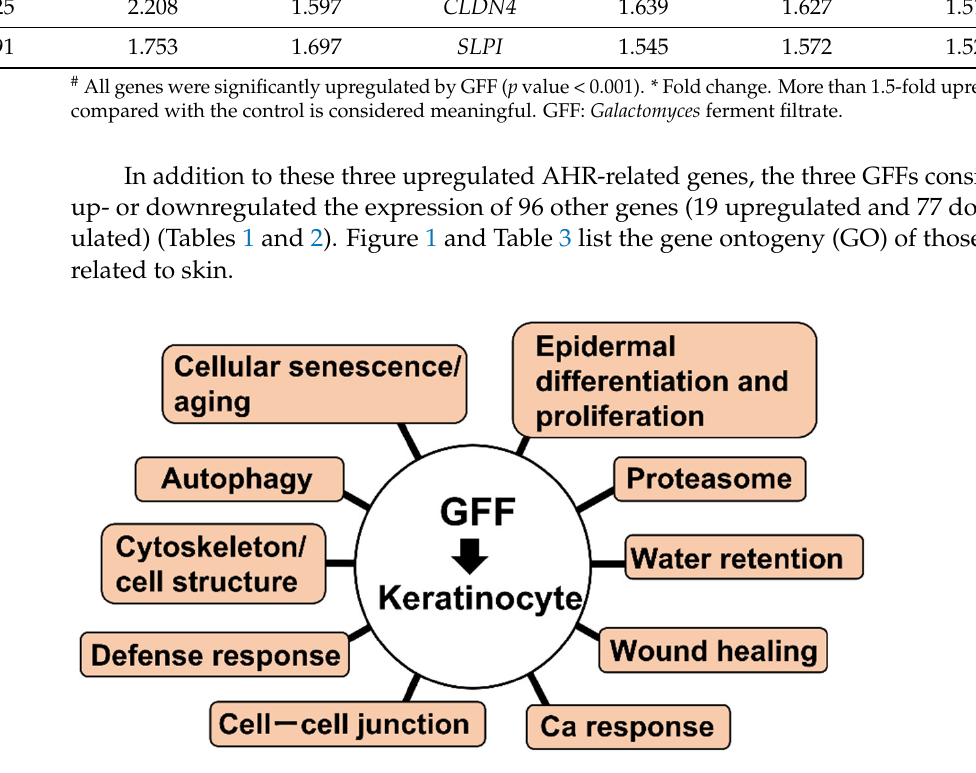
Figure 1. Representative gene groups with modified expression in GFF-treated keratinocytes. GFF: Galacommyces ferment filtrate. Table 3. Gene ontology of skin-related genes up- and downregulated by GFF.